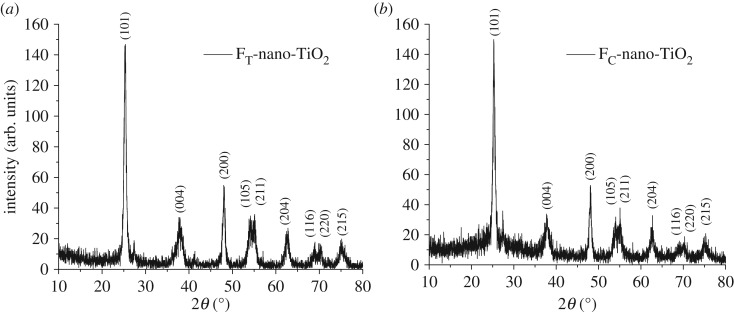
XRD patterns of organofunctionalized nano-TiO2, (a) FT-nano-TiO2 and (b) FC-nano-TiO2.